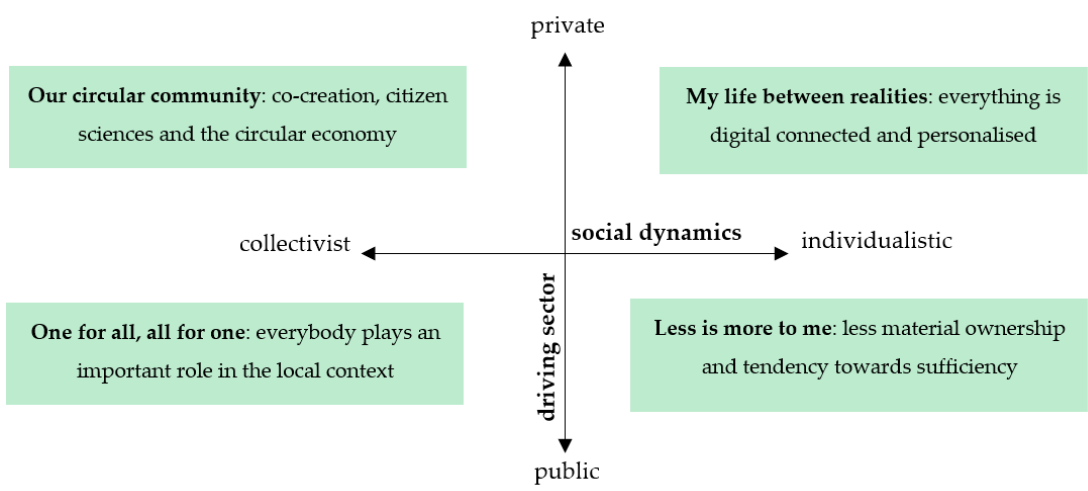
Figure 3. Overview of the four future scenarios.